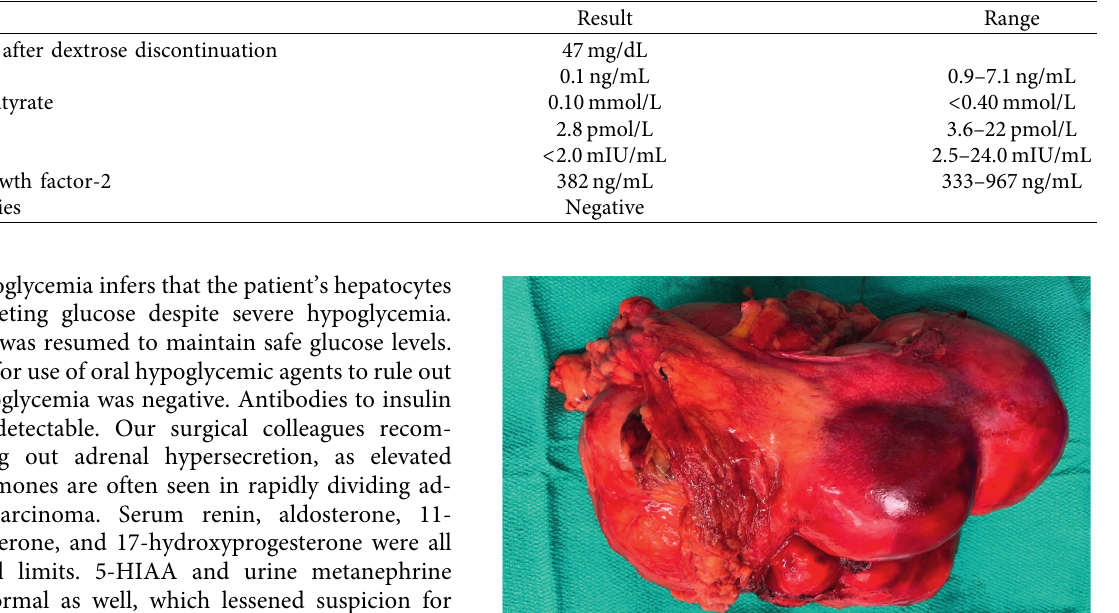
Table 1: Relevant laboratory values and corresponding reference ranges.